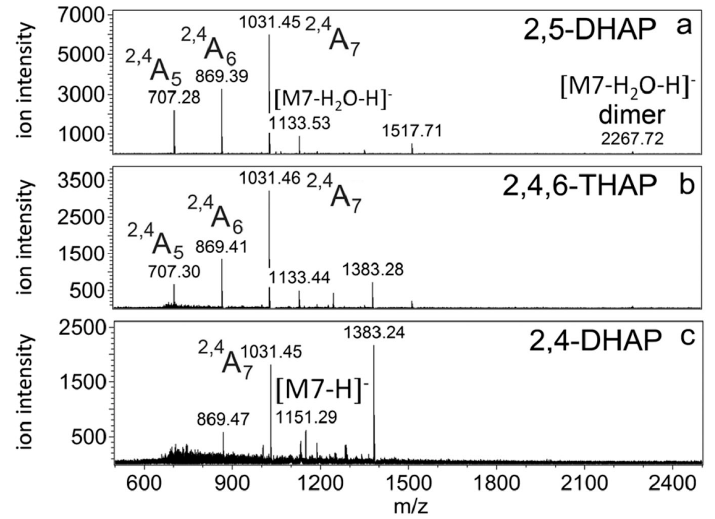
Figure 18. (-) MALDI-TOF reflectron spectra of maltoheptaose using the following matrices. ( a ) 2,5- DHAP (saturated); ( b ) 2,4,6-THAP (25 mg/mL); ( c ) 2,4-DHAP (25 mg/mL). Reproduced